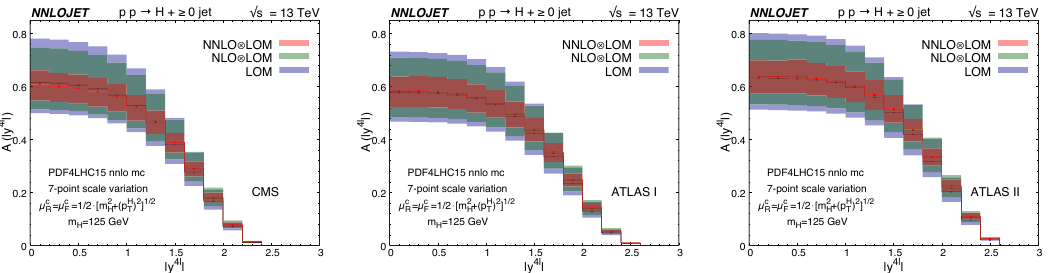
Figure 6. Acceptance of Higgs boson rapidity distributions for Higgs boson production up to NNLO for CMS (left), ATLAS I (centre) and ATLAS II (right)